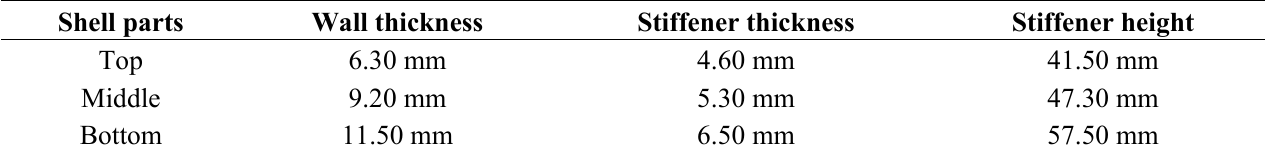
Table 4. Optimization results for design parameters.